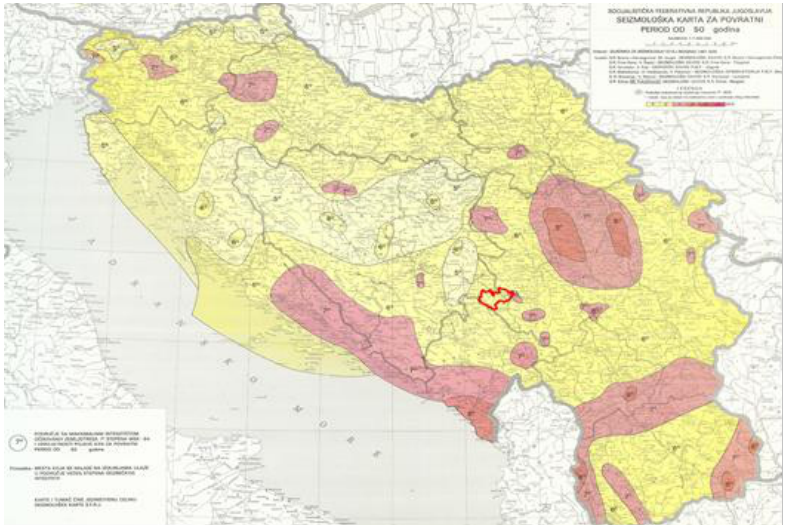
Figure 3. Seismic map of ex SFRY for a return period of 50 years, Seismology Community of SFRY, (Milovanović et al.,